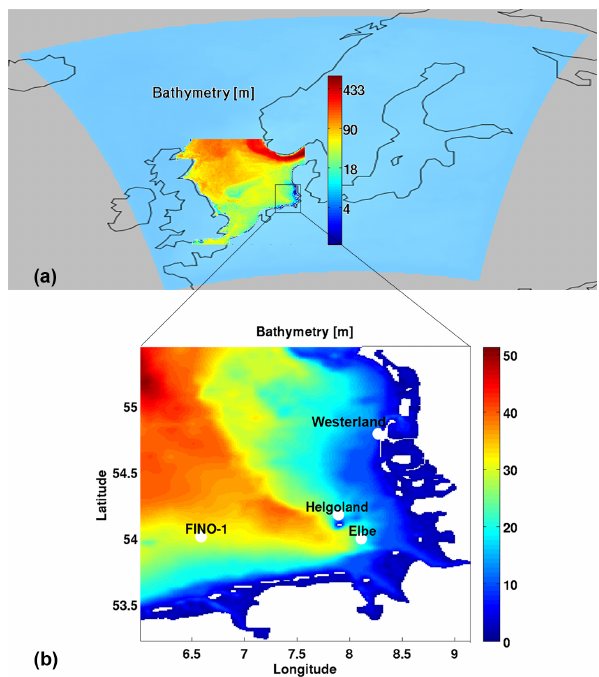
Figure 1. (a) Bathymetry (m) of the North Sea embedded in the COSMO model area (using a logarithmic scale) and (b) bathymetry (m) of the German Bight as used in the WAM model. The positions of four waverider buoys used for the validation are in- dicated,